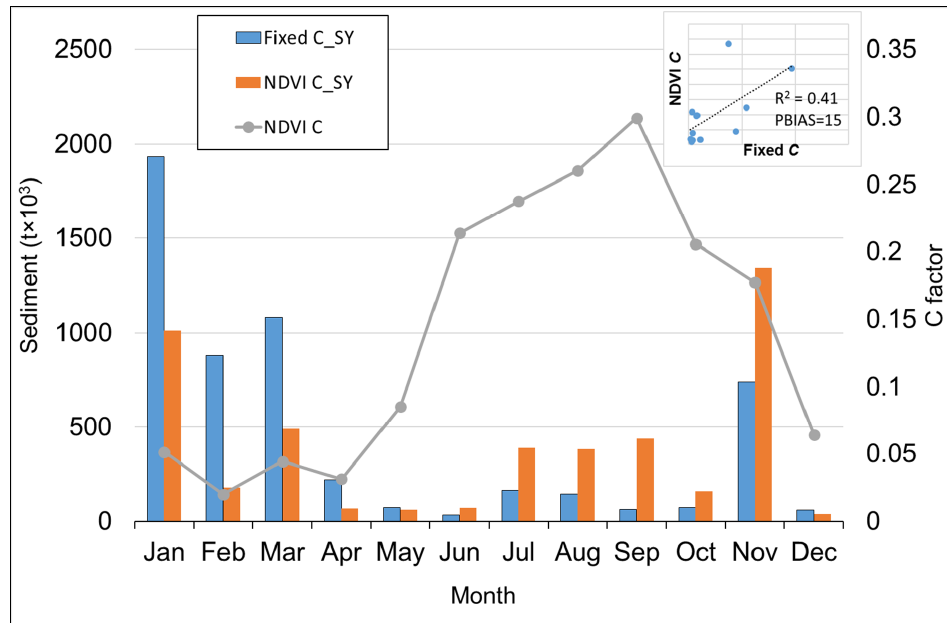
Figure 5. Distribution of sediment yield (SY) simulated using the fixed and variable (NDVI) C factors for catchment T35C in 2016.